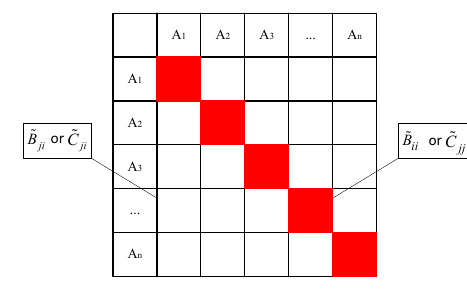
Fig. 1. Information transfer for the predecessor and the successor activities